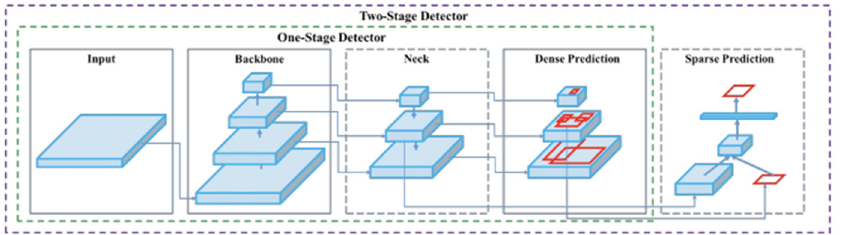
Figure 4. Training architecture (https://iq.opengenus.org/yolov4-model-architecture/, accessed on 20 December 2022).